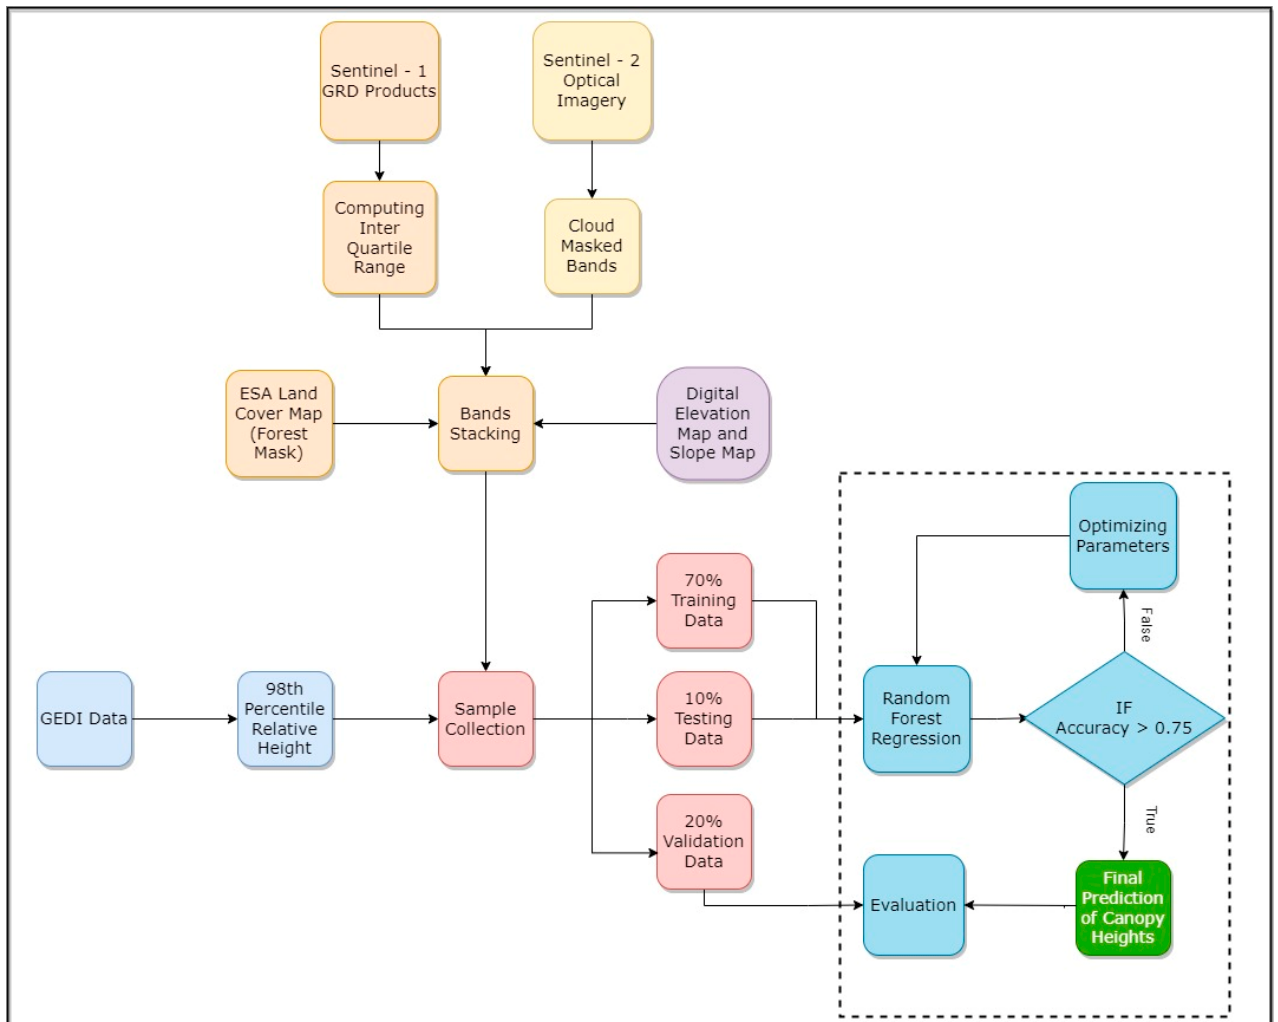
Figure 3. A flowchart of the machine learning-based canopy height estimation process.